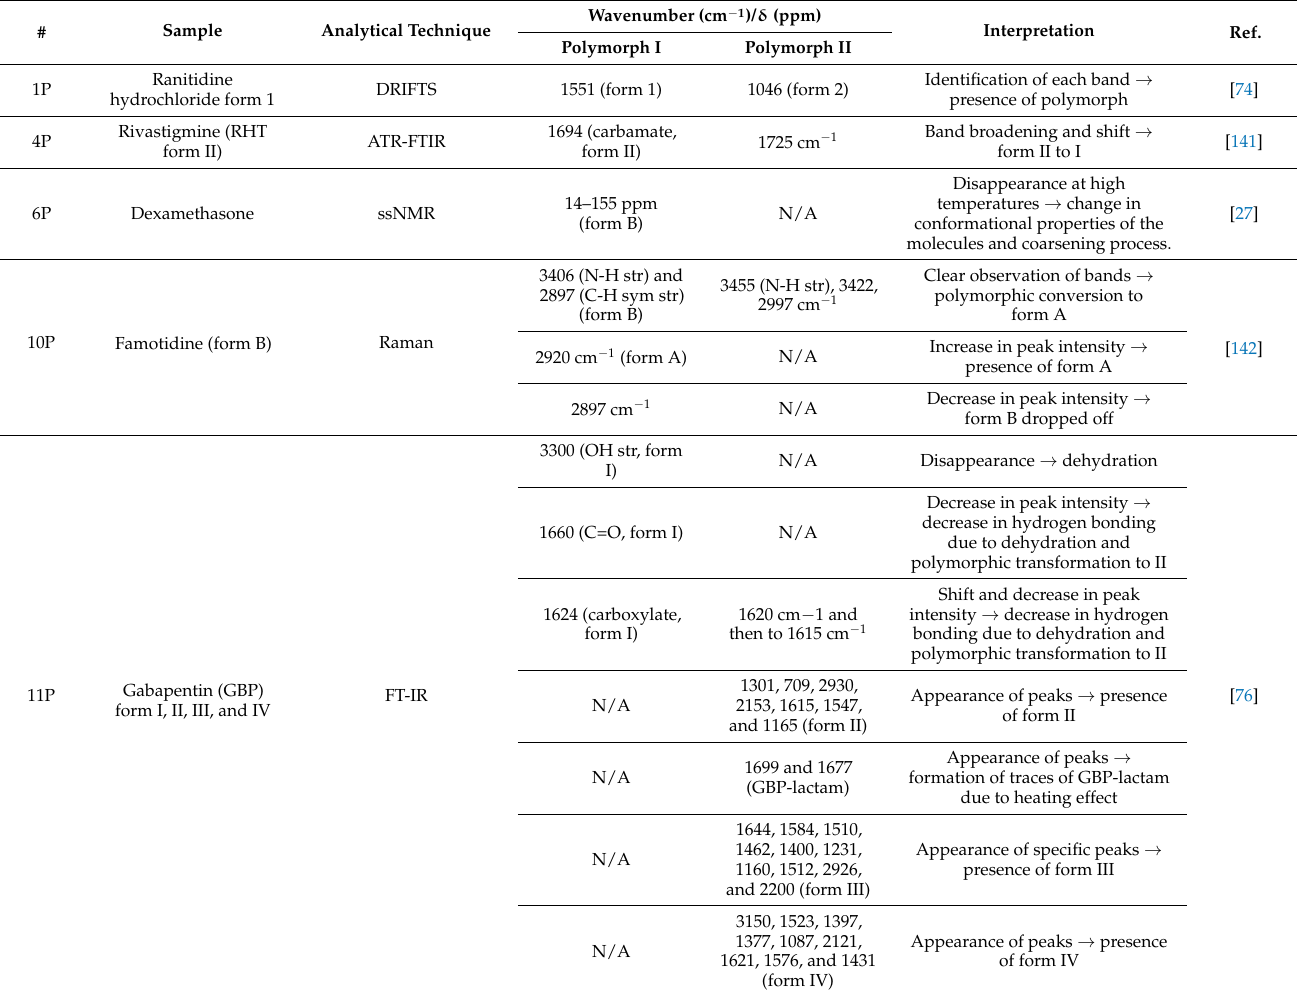
Table 8. Overview of structural characterization by spectroscopy of drug polymorphs obtained by